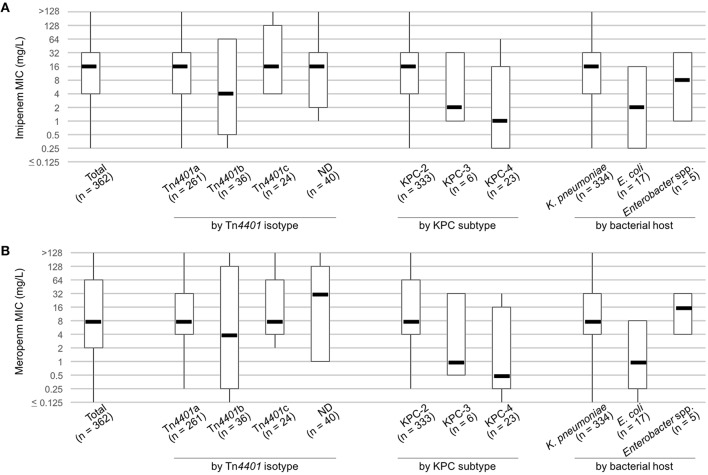
MICs of imipenem (A) and meropenem (B) in KPC producers. Boxplots present MIC50, MIC10, and MIC90 values, with whiskers showing the maximum and minimum MICs of the group.